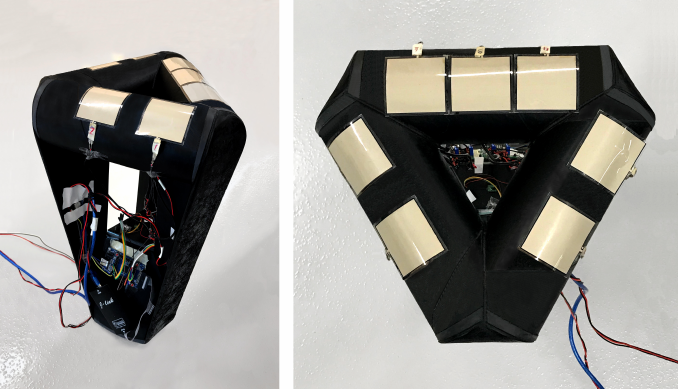
Figure 1. Left panel: The view of chair from its side. The accelerometer is attached to the base of the chair. Right panel: The view of chair from above: seven FSRs were placed on the top of the chair. The side with three FSRs is the rear orientation.